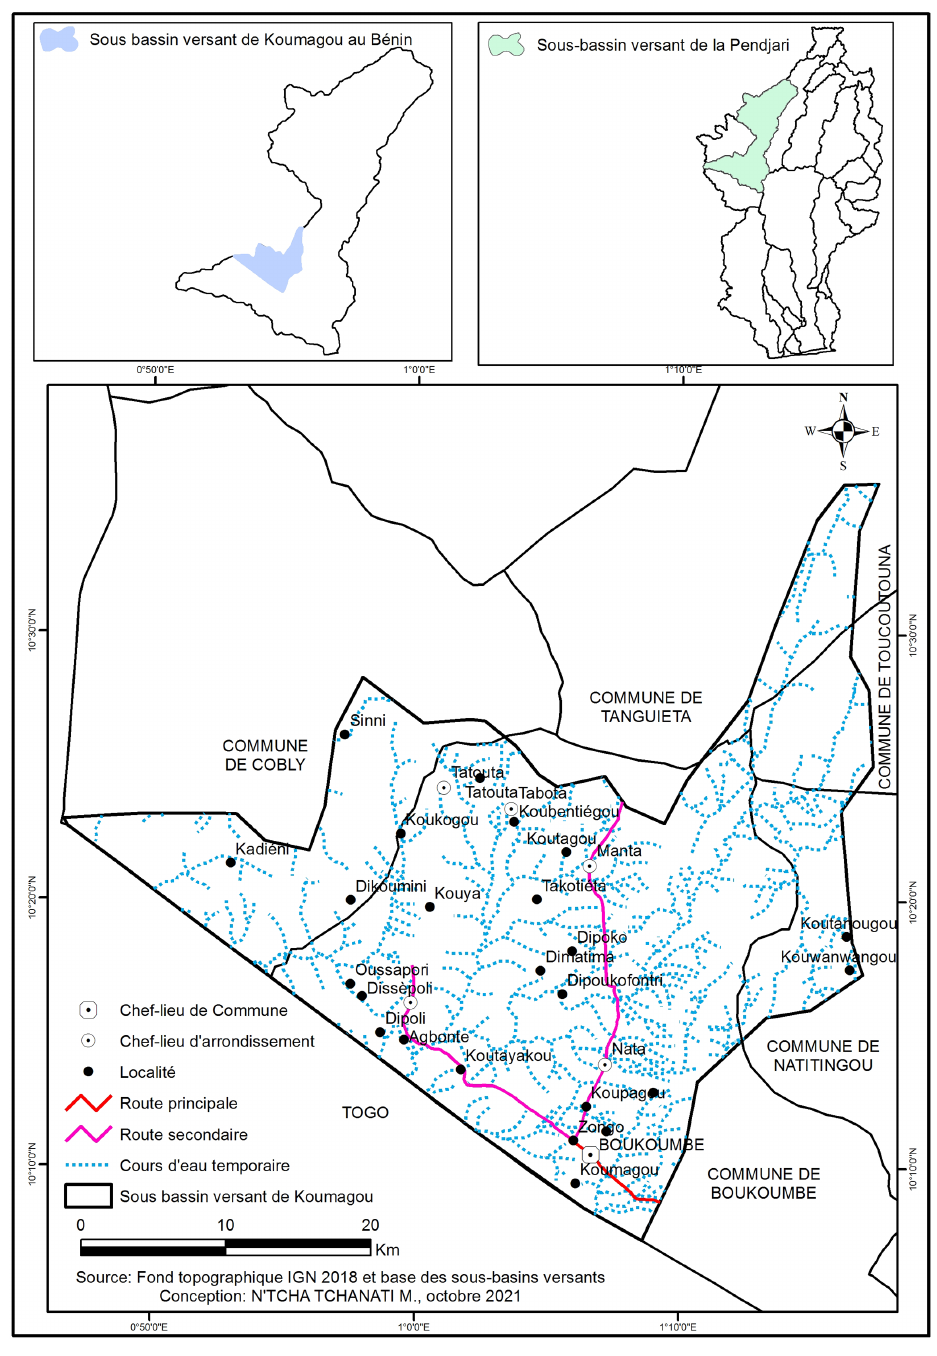
Figure 1. Situation géographique du sous-bassin de Koumagou à